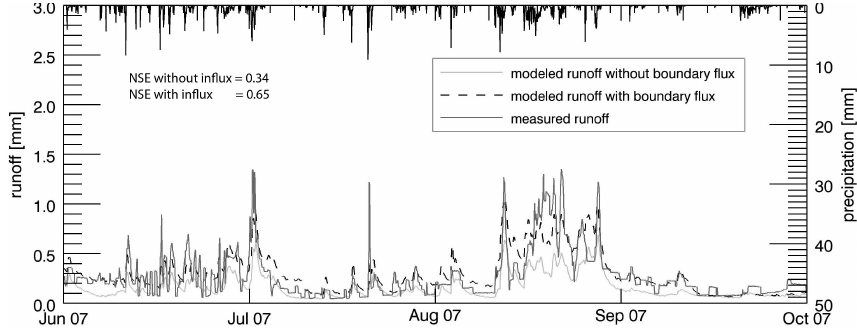
Fig. 16. Measured runoff, modeled runoff and modeled runoff with implemented boundary flux (20-day time increment) for June to Octo- ber 2007 for subbasin K¨onigsseetal. Linear Nash Sutcliffe Efficiency shows model performance from June to October 2007.